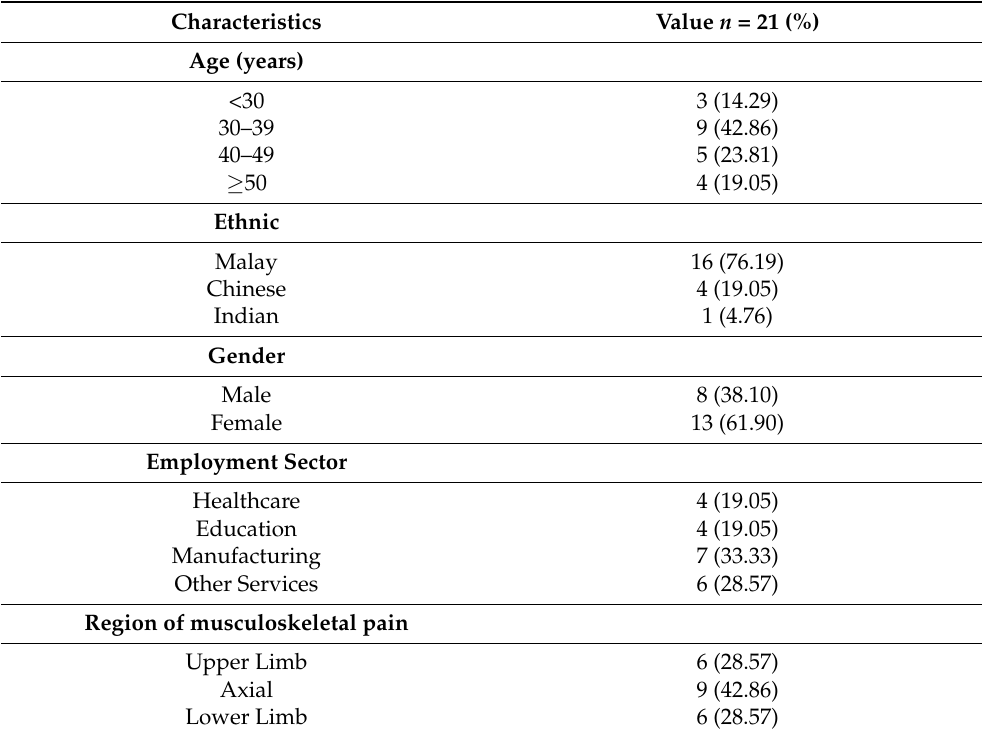
Table 2. Demographic characteristics of participants ( n =